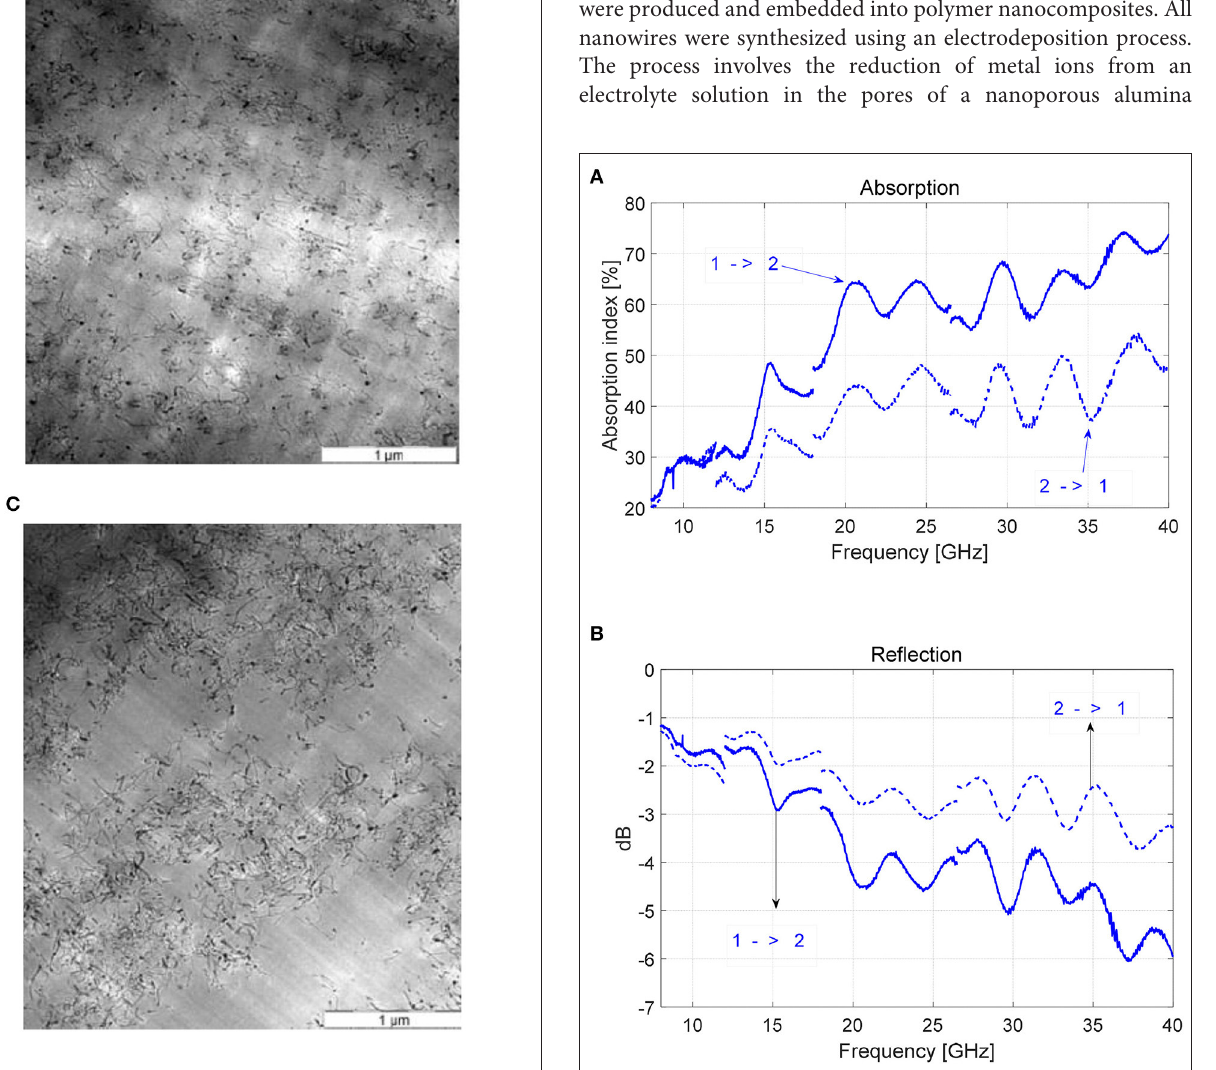
FIGURE 3 | Multilayer gradient topology (A) and TEM images of PC-CNT melt-blended composites with 1 wt.% CNT concentration (B) or 7.5 wt.% CNT concentration (C) .